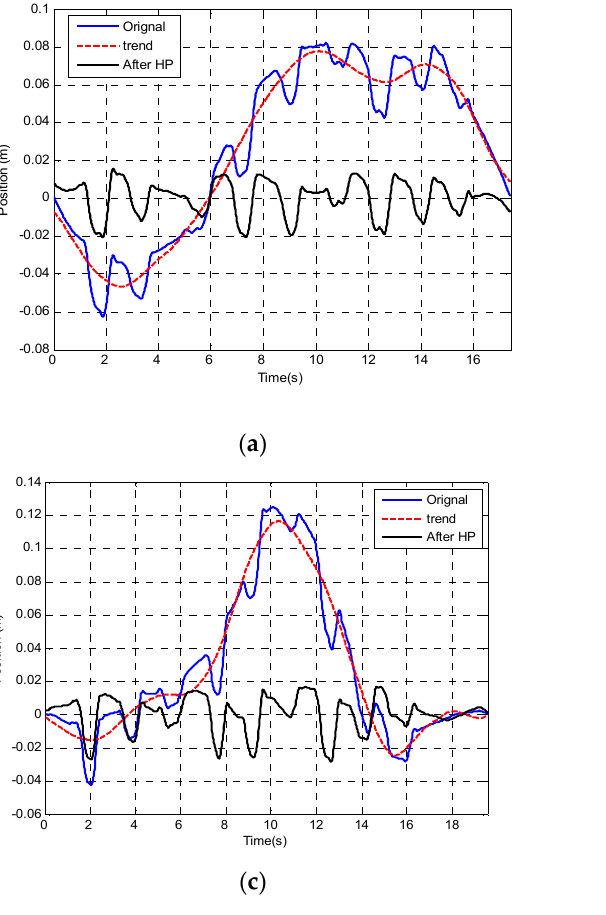
Figure 16. Drift removal by HP filter compared with kinematic model tracking result. 4.4. Comparisons between Different Drifts Correction Methods A comparison of the different drift correction methods is shown in Figure 17. The spearman correlation coefficient has been calculated in comparing the different drifts cor- rection method, in which the plots after different correction methods are compared with